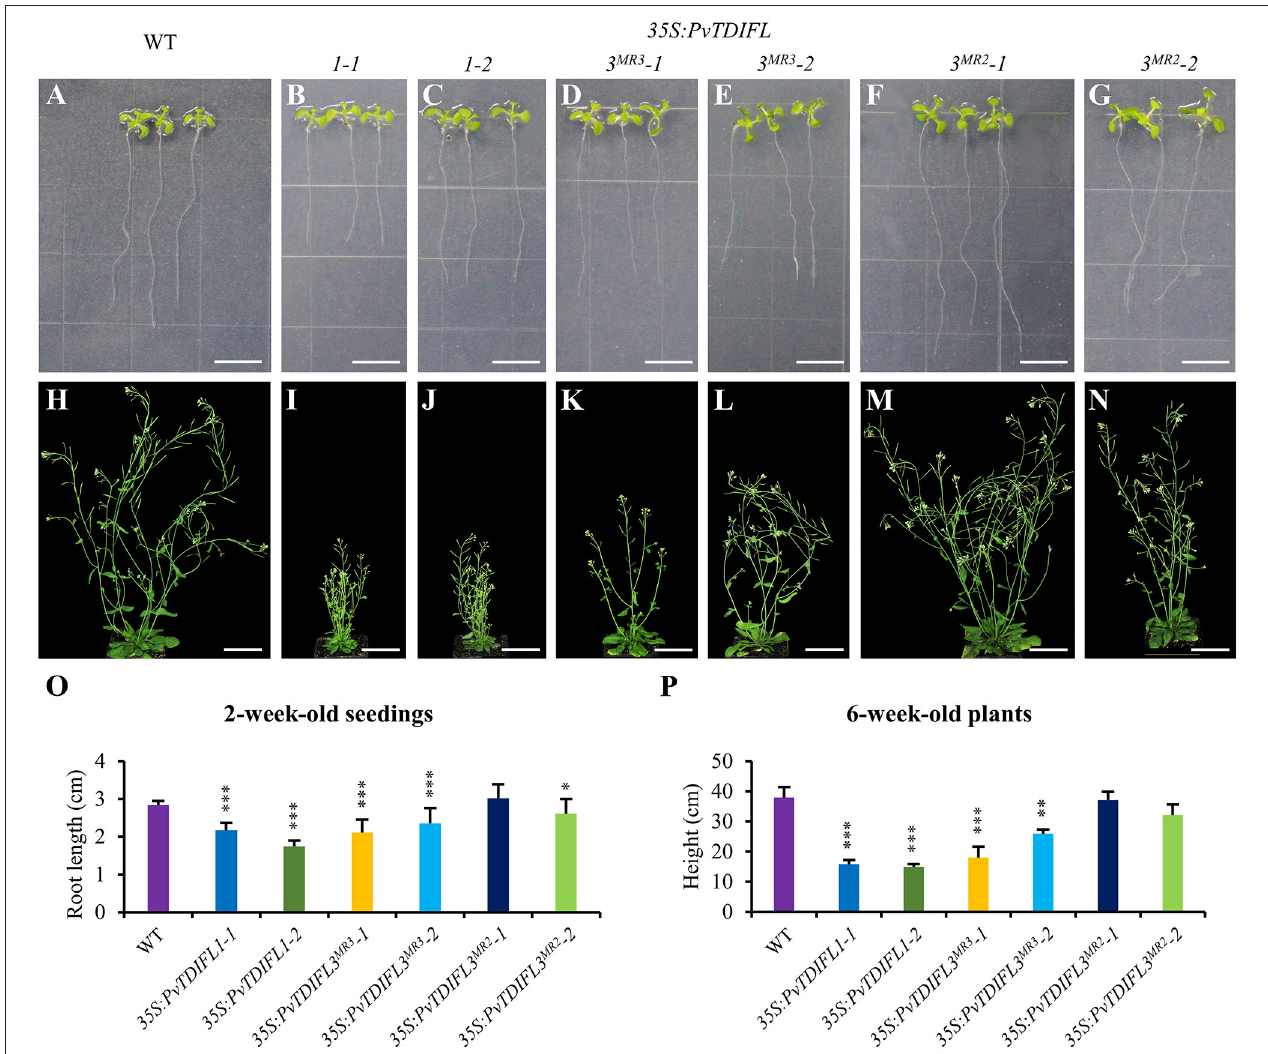
FIGURE 6 | Morphology of 2 and 6-week-old Arabidopsis expressing PvTDIFL transgenes. (A–G) Morphological observations of 2-week-old seedlings from WT (A) , and transgenic plants harboring 35S:PvTDIFL1-1 (B) , 35S:PvTDIFL1-2 (C) , 35S:PvTDIFL3 MR 3 -1 (D) , 35S:PvTDIFL3 MR 3 -2 (E) , 35S:PvTDIFL3 MR 2 -1 (F) , 35S:PvTDIFL3 MR 2 -2 (G) transgenes grown on vertical plates. (H–N) Morphological observation of 6-week-old seedlings from WT (H) and transgenic plants harboring 35S:PvTDIFL1-1 (I) , 35S:PvTDIFL1-2 (J) , 35S:PvTDIFL3 MR 3 -1 (K) , 35S:PvTDIFL3 MR 3 -2 (L) , 35S:PvTDIFL3 MR 2 -1 (M) , 35S:PvTDIFL3 MR 2 -2 (N) transgenes grown in soil. (O) Quantitation analysis of root length of 2-week-old seedlings. (P) Heights of 6-week-old plants. *, **, and *** indicates statistically significant differences from WT at p < 0.05, p < 0.01, and p < 0.001, respectively. Sample size n = 24 (biological replicates) for the vertical plates and n = 10 (biological replicates) for